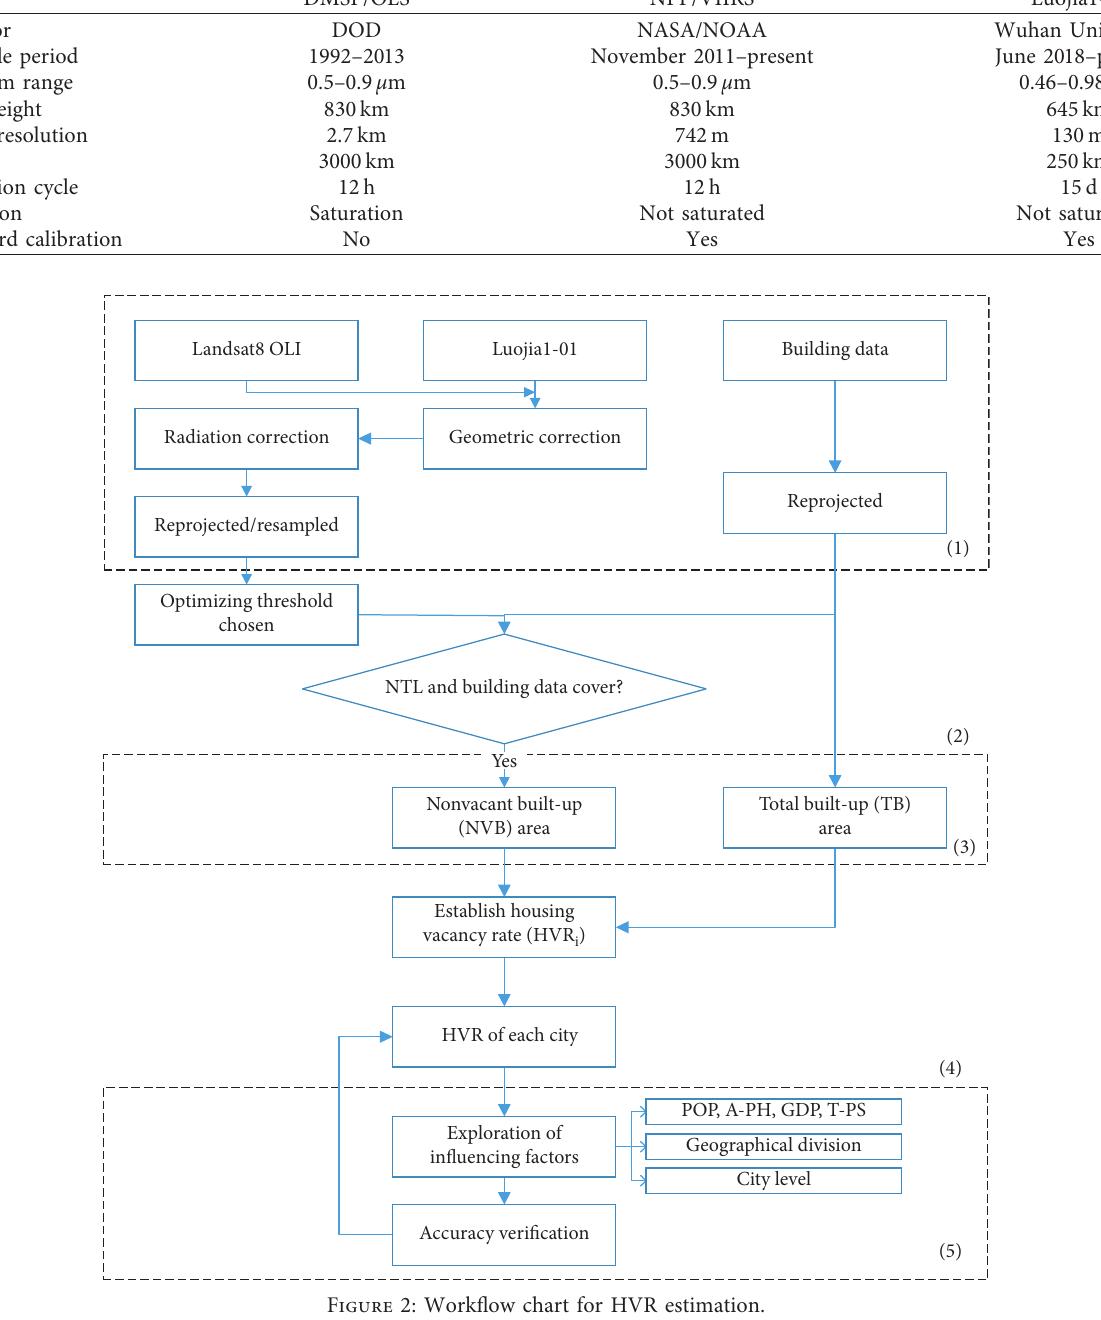
Figure 2: Workflow chart for HVR